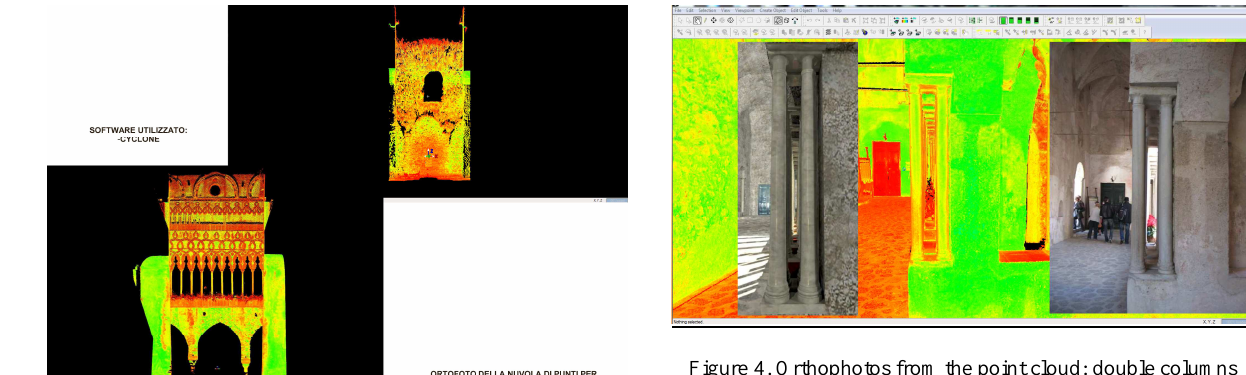
Figure 4. Orthophotos from the point cloud: double columns